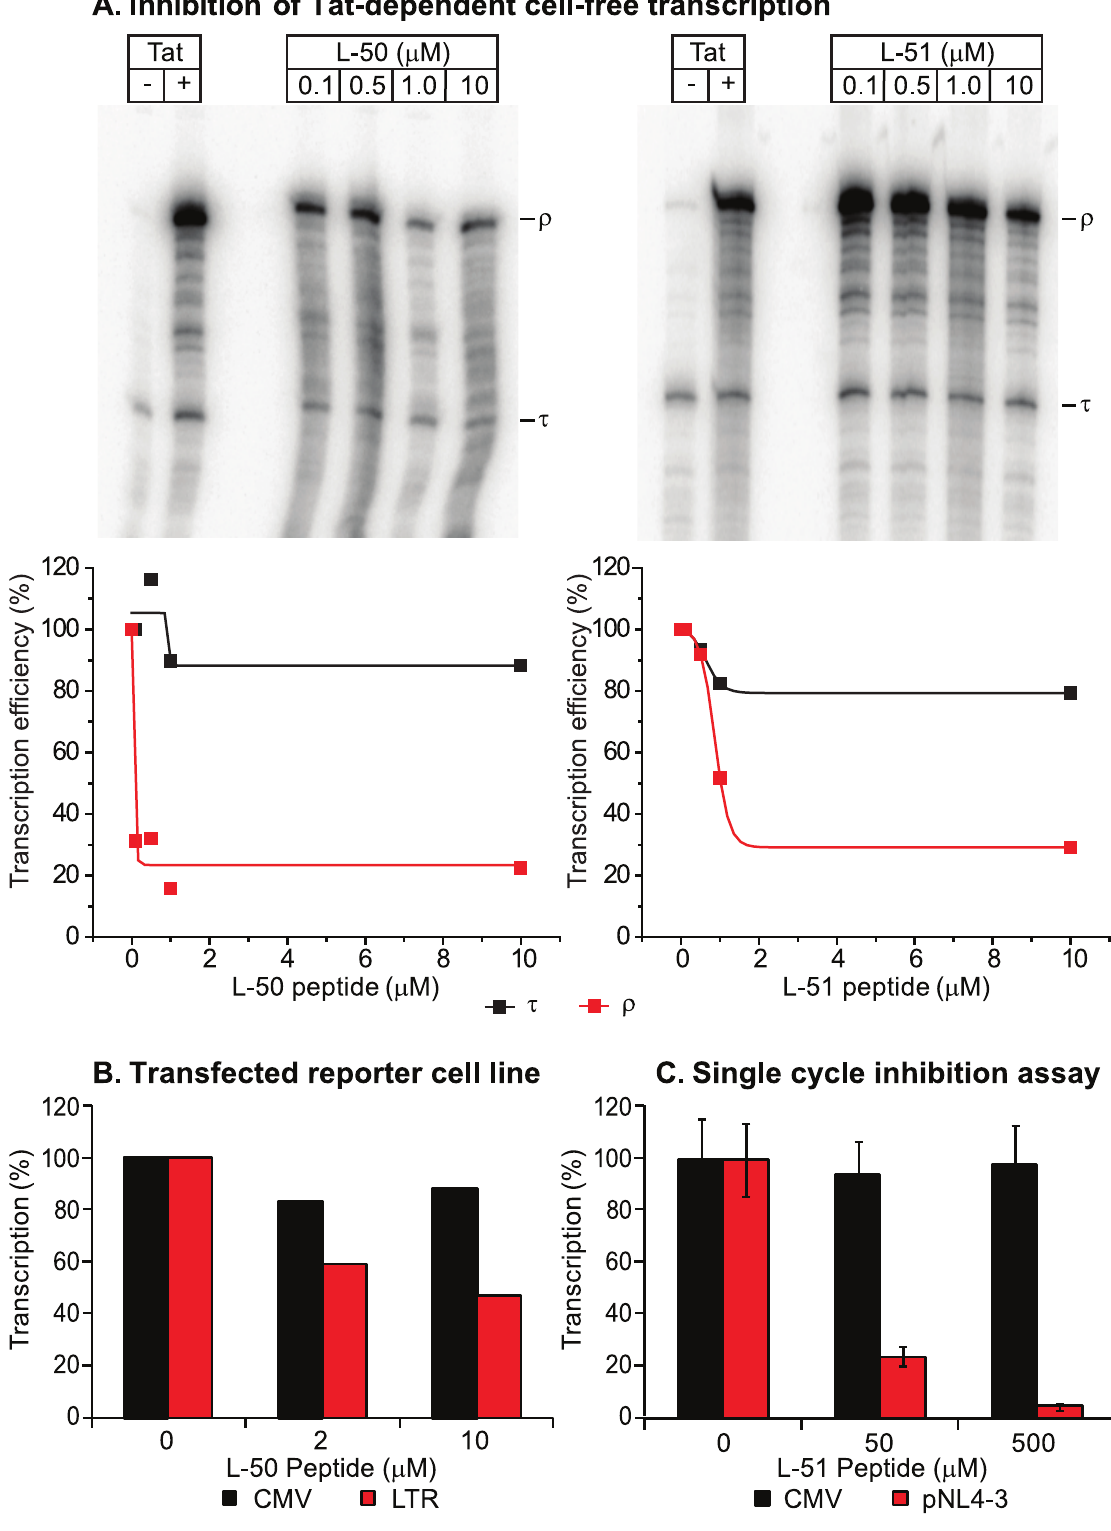
Figure 3. L50 inhibition of Tat-dependent transactivation in cell-free, reconstituted transcription system and in transfected cells. DNA templates carrying the HIV promoter were transcribed in the presence or absence of recombinant Tat protein ( + Tat) and increasing concentrations of the Tat peptidomimenic (L-50, left panel; L-51, right panel) ( A ); r identifies full-length transcripts and t identifies transcripts ending at the terminator sequence inserted proximal to the promoter. Relative transcription levels of the Tat-dependent full-length transcript r decreased by 4-fold with the Tat peptidomimetic while the Tat-independent t product remained almost unaffected. ( B ) 293T cells were transfected with the